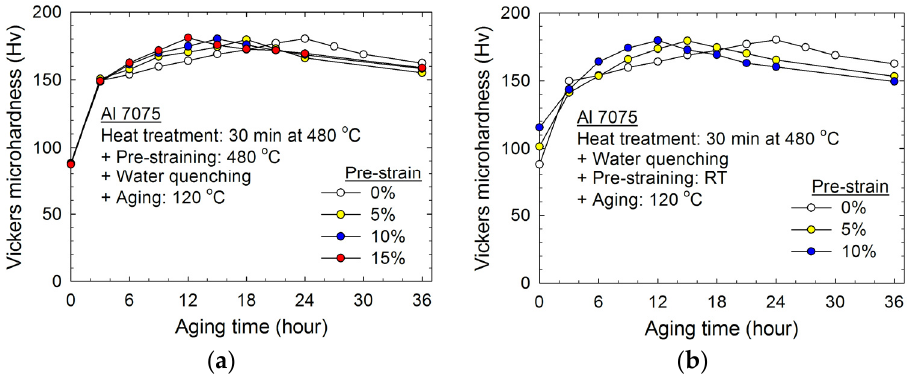
Figure 5. Variations of Vickers microhardness with aging time for the Al 7075 alloy with different amount of pre-strain at ( a ) 480 °C and ( b ) RT.